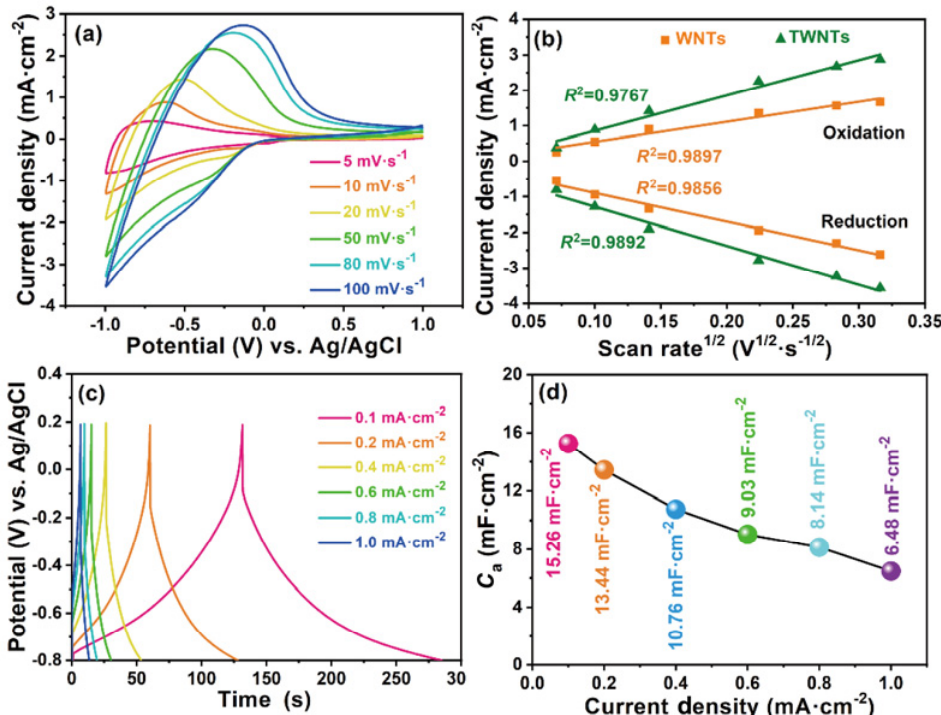
Fig. 4 Electrochemical data of the TWNTs film in 1 M LiClO 4 /PC electrolyte. CV curves at various scan rates (a), the cathodic/anodic peak current density as a function of the square root of the scan rates for WNTs and TWNTs films (b), GCD curves under various discharging densities (c), and the corresponding areal capacitances